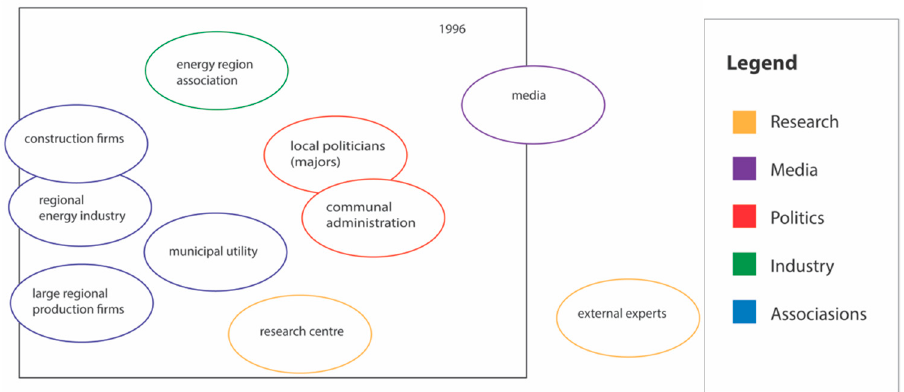
Figure 2. Aggregation of individual conceptual maps of the social subsystem in 1996 (authors ′ own elaboration).